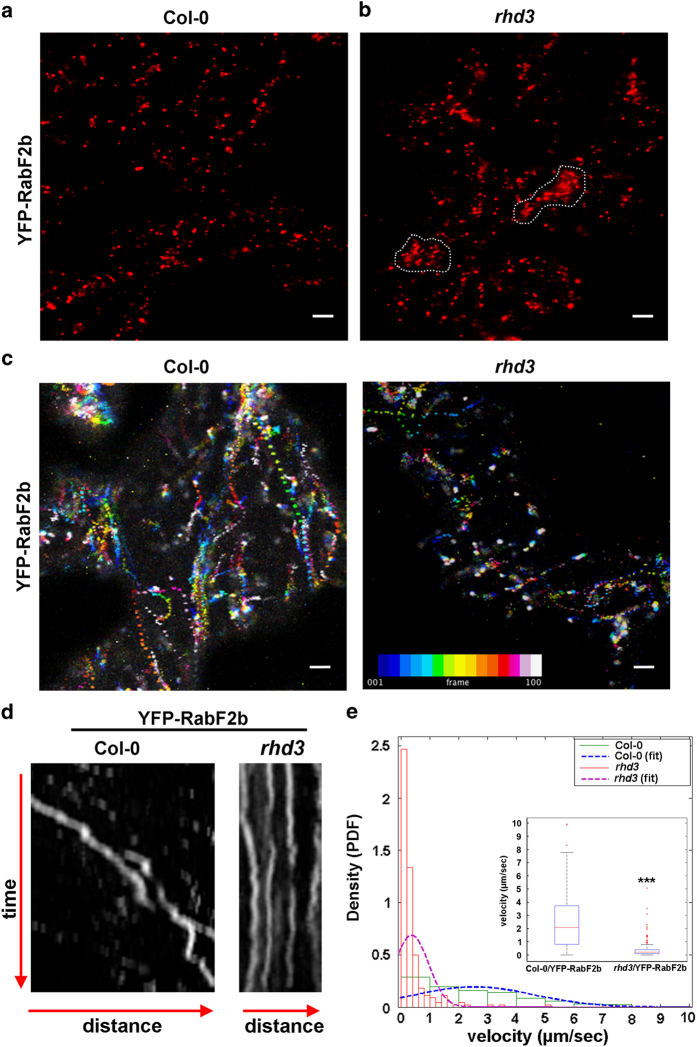
Spatiotemporal distribution of endosome is compromised in rhd3. (a, b) Confocal images of cotyledon epidermal cells in wild type (a; Col-0) and rhd3 (b) (rhd3) expressing the endosome marker YFP-RabF2b, note the clustering of endosomes in rhd3 (circled by dotted line). (c) Intracellular streaming of endosome organelles in Col-0 and rhd3 mutant presented as super-imposed frames of a time-lapse sequence (25 s). In each frame, organelles have been assigned a color, with dark red representing the position of organelles in initial frames and white indicating the position of the organelles in the last frame. Intermediated colors are presented at the bottom of the panel. Reduced streaming of endosomes in rhd3 is evidenced by local superimposition of colors compared with wild type. (d). Representative kymographs for Col-0/YFP-RabF2b and rhd3/YFP-RabF2b. (e) Endosome movement of 221 YFP-RabF2b-labeled endosomes in Col-0 (red) and rhd3 (green) is expressed as histograms and probability density function (PDF) of the velocity distributions, which were fitted (blue and magenta dashed lines) using distribution tool (Matlab). Statistical analysis was performed using Student’s t-test (***P<0.0001). The inset plot shows the average velocity for endosomes in wild type and mutant cells. Scale bars, 5 μm.